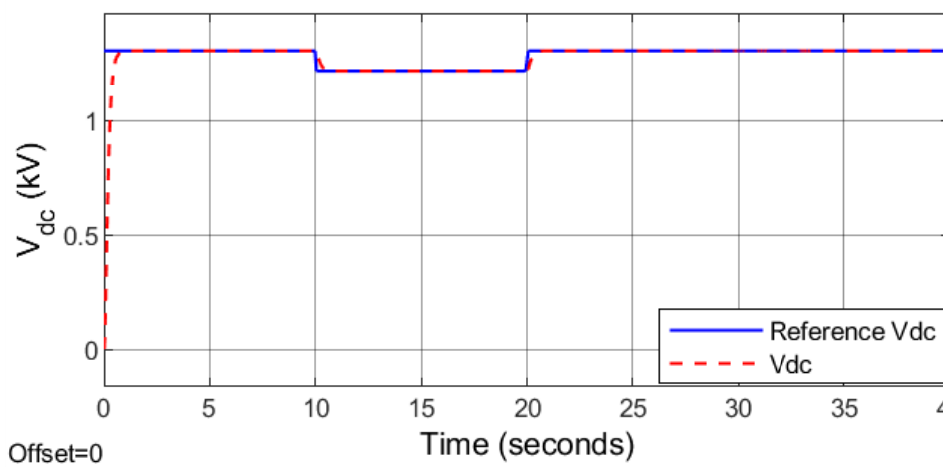
Figure 3. Scenario 1: tracking performance of the DC-link